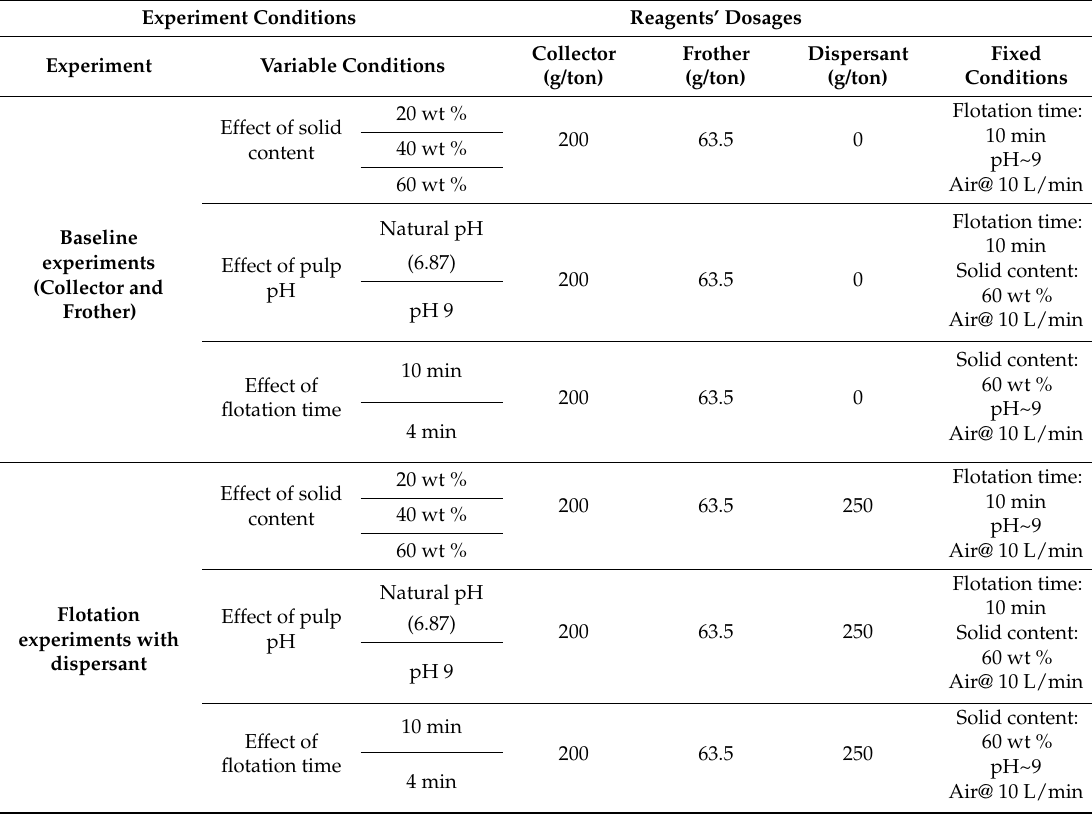
Table 1. Different conditions tested in the flotation of phosphate